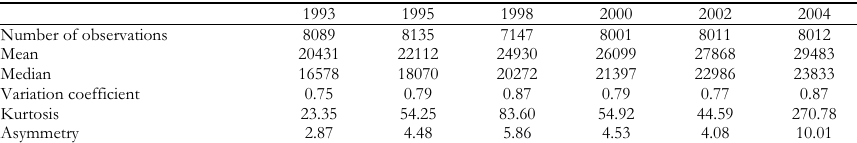
Income of Italian households from 1993 to 2004, thousand euro